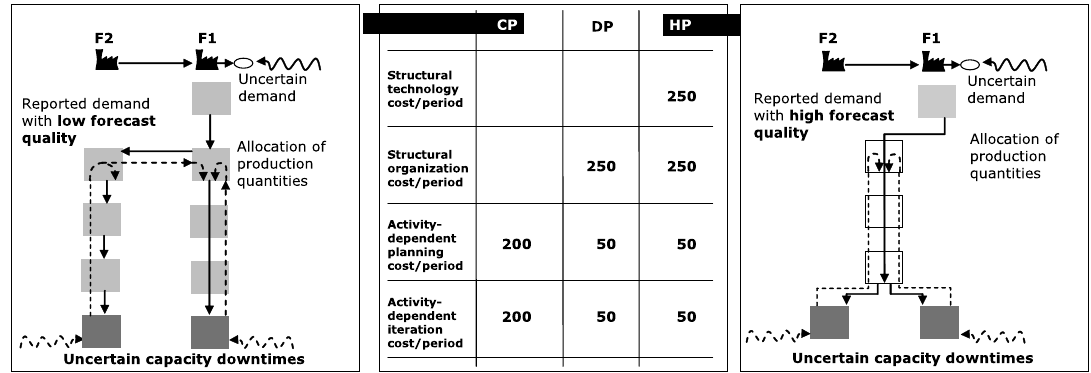
Figure 5. “Information flow schemes and resulting coordination cost [1.000 € /